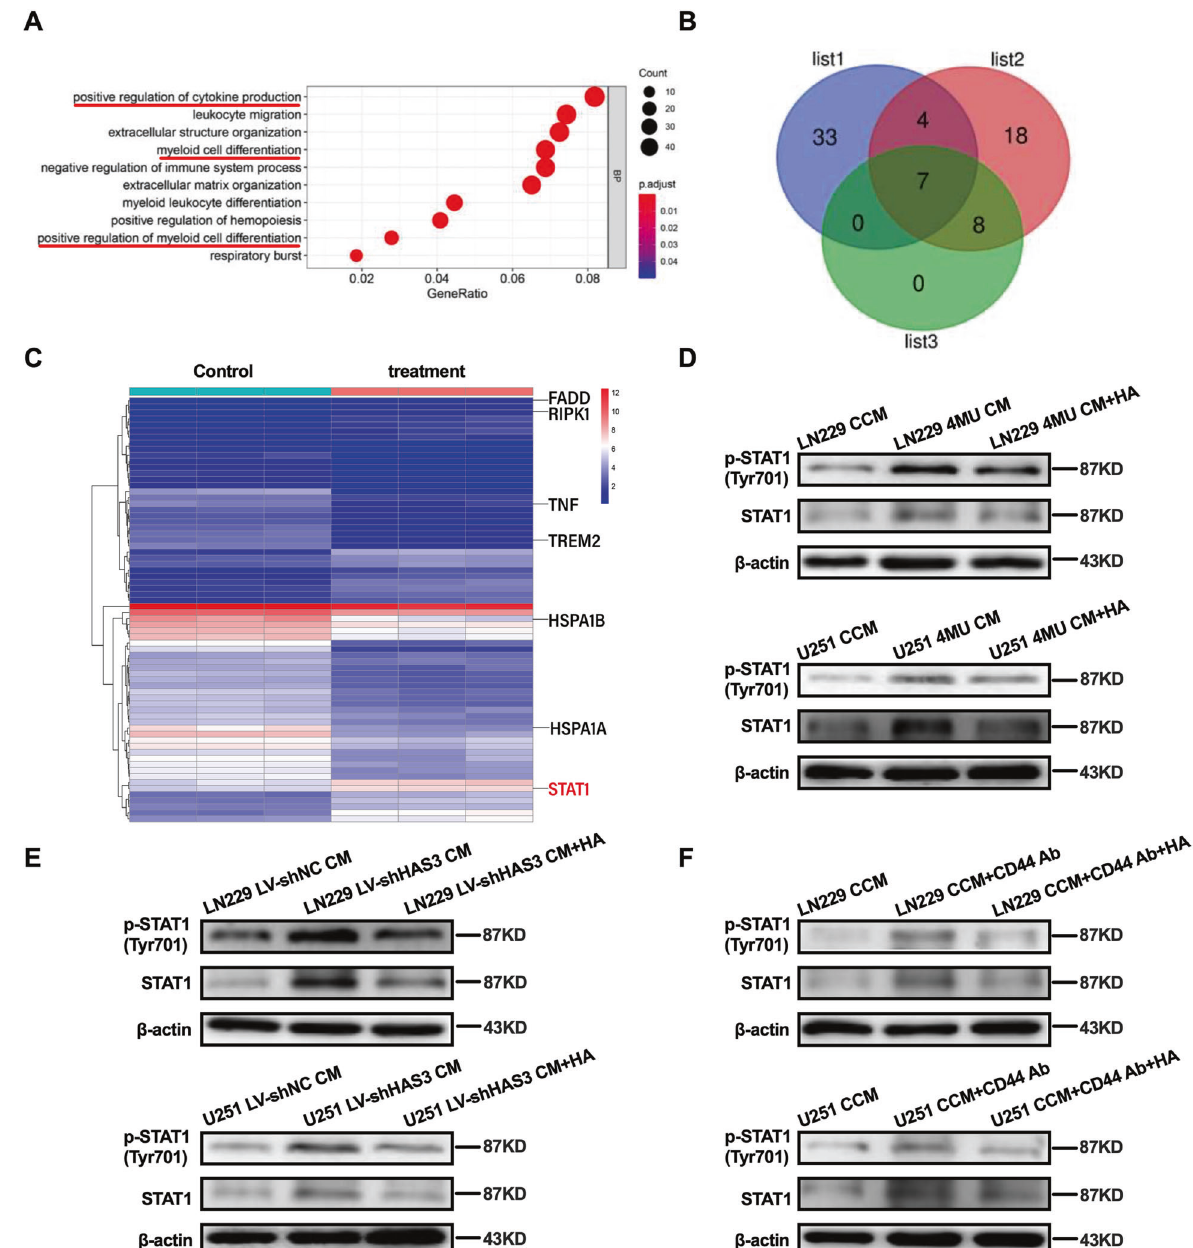
Fig. 5 Interfering HA synthesis in glioblastoma or disrupting the binding of HA to CD44 on macrophages promotes M1 macrophages polarization via STAT1 activation. A Differentially expressed genes were subjected to GO analysis, and the results showed that these differentially expressed genes were highly associated with the following three biological processes: positive regulation of cytokine production, myeloid cell differentiation and positive regulation of myeloid cell differentiation. B The differentially expressed genes common to the above three biological processes were further analyzed by a Venn diagram, and 7 overlapping genes were identi fi ed. (list1: positive regulation of cytokine production; list2: myeloid cell differentiation; list3: positive regulation of myeloid cell differentiation) C Heat map of the differentially expressed genes involved in the above three biological processes; the red mark indicates STAT1. D Macrophages were cultured with 4MU CM for 48 h, and one of the treatment groups was extra treated with exogenous HA (25 μ g/ml). The relative protein levels of p-STAT1 and STAT1 in macrophages were examined by Western blotting. E Macrophages were cultured with LV-shHAS3 CM for 48 h, and one of the treatment groups was extra treated with exogenous HA (25 μ g/ml). The relative protein levels of p-STAT1 and STAT1 in macrophages were examined by Western blotting. F Macrophages pretreated with the anti-CD44 antibody (6 μ g/ml) were cultured with CCM for 48 h, one of the treatment groups was extra treated with exogenous HA(25 μ g/ml). The relative protein levels of p-STAT1 and STAT1 in macrophages were determined by Western blotting. Error bars show mean ± SD. * P < 0.05, ** P < 0.01, and *** P < 0.001. breast cancer [34]. Other researchers also con fi rmed that the melanoma cells via the Toll-like receptor (TLR) 4 and NF- κ B binding of HA to CD44 can promote the upregulation of M2 pathways [33]. Some studies have reported that abnormal HA polarization-related genes in human THP-1 cells via the STAT3 accumulation is correlated with an increased number of M2 pathway [35]. Tyrosine phosphorylation and dimerization of STAT1 macrophages via activation of the ERK1/2-STAT3 pathway in Cell Death Discovery (2022)